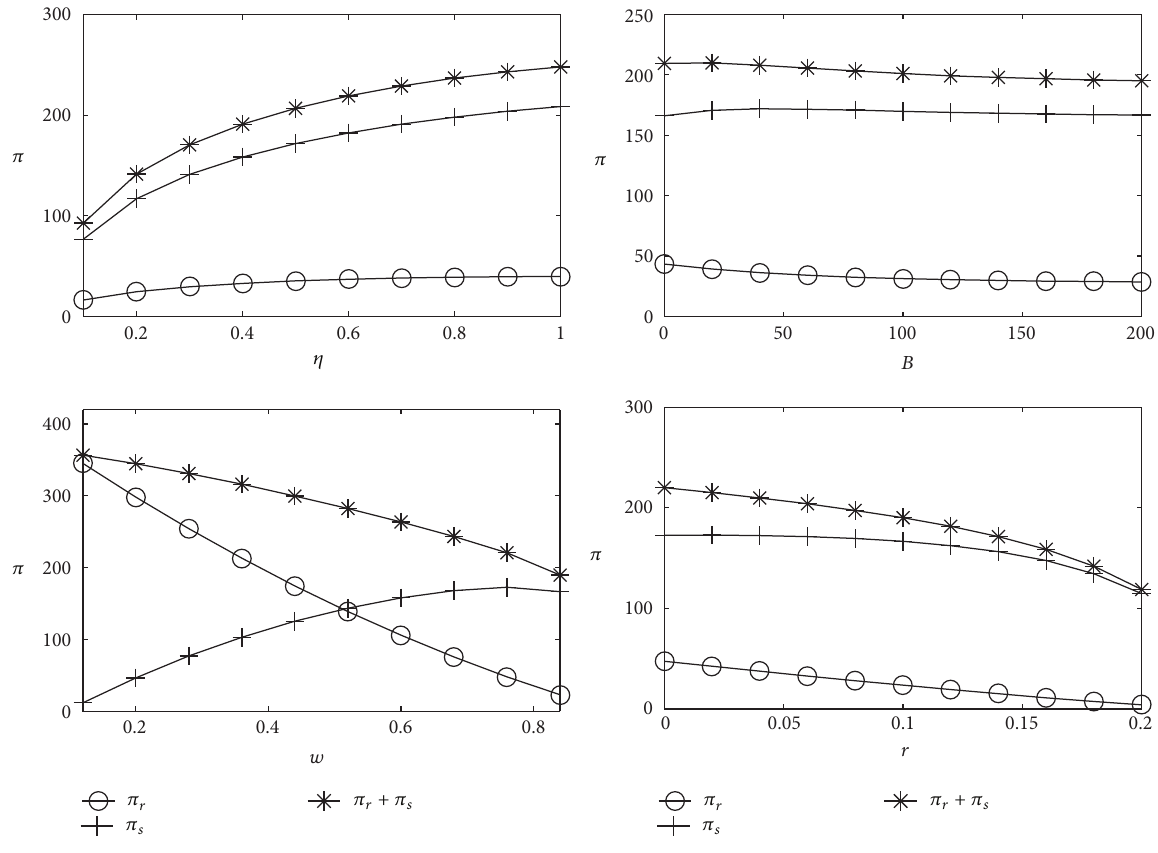
Figure 2: Impact of 𝜂 , 𝐵 , 𝑤 , and 𝑟 on the profit of member in supply chain.